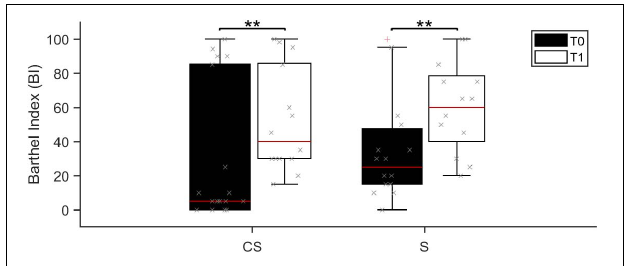
FIGURE 1 | Barthel Index score assessed at baseline (T0, black boxes) and at the 3 months follow-up (T1, white boxes). BI, Barthel Index; CS , cortico-subcortical stroke patients; S , subcortical stroke patients. ** p < 0.01.